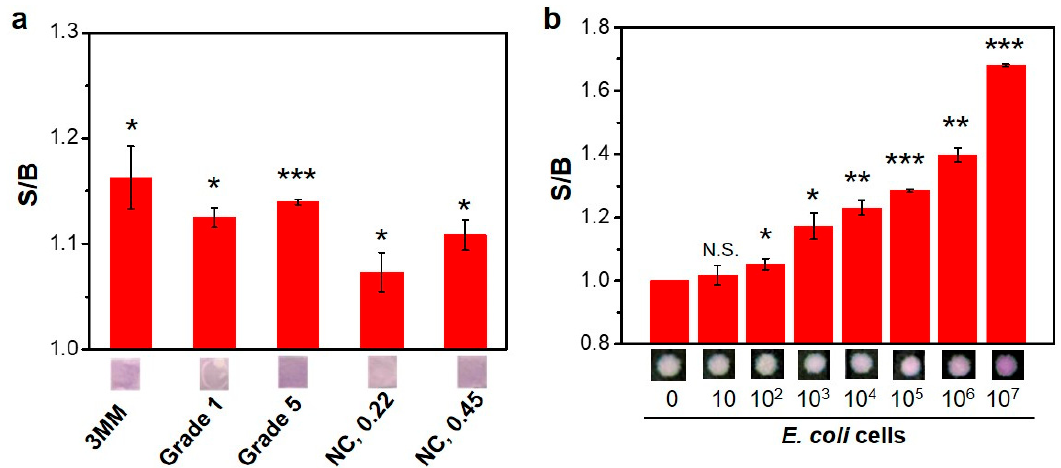
Figure 2. ( a ) Characterization of the protein extraction capabilities of the different papers using BCA protein assay. ( b ) On-paper protein extraction from varying concentrations of E. coli . Each datum is the average of three measurements, and the error bar is the standard deviation. N.S., not significant; * p < 0.05, ** p < 0.01 and *** p < 0.001; obtained using unpaired t-test.